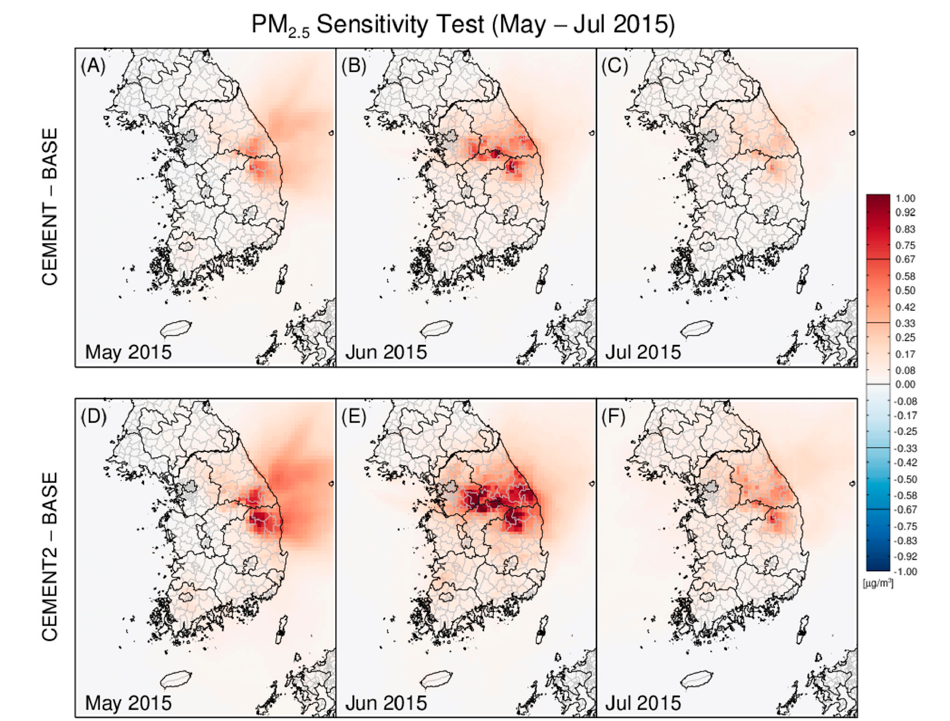
Figure 8. Impact of emissions by the cement industry on monthly averaged PM 2.5 concentration during May to July 2015. Simulated impacts are shown based on the current CAPSS 2013 emissions inventory ( A – C ) and satellite measurements ( D – F ).